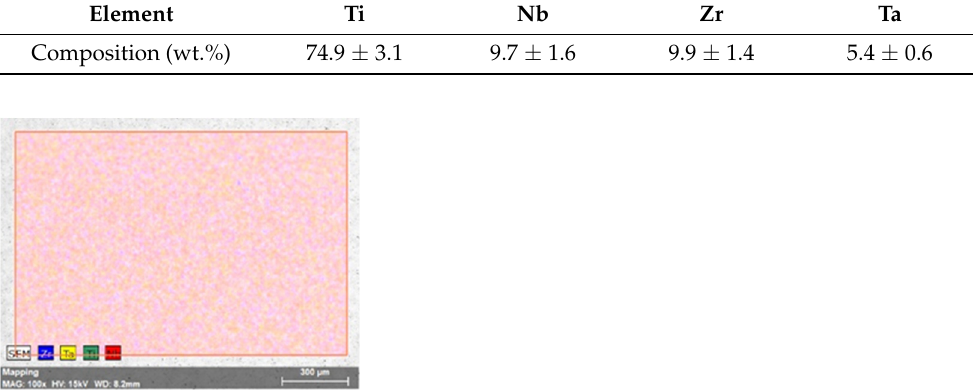
Figure 1. Homogeneous element distribution of the TNZT alloy (magnification 100×).